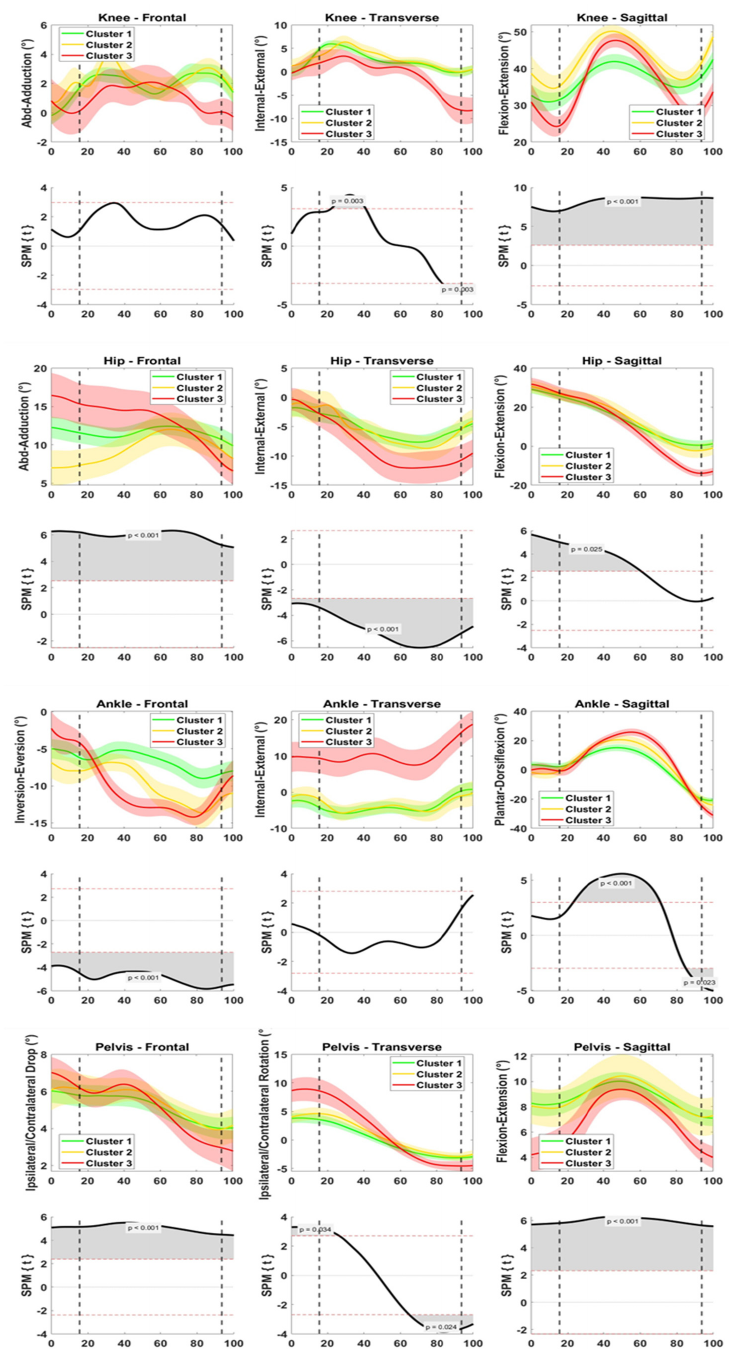
Figure 3. Joint kinematics of knee (1st row), hip (3rd row), ankle (5th row), and pelvis (7th row) collected on the field during change of direction in game. Data are clustered according to the knee